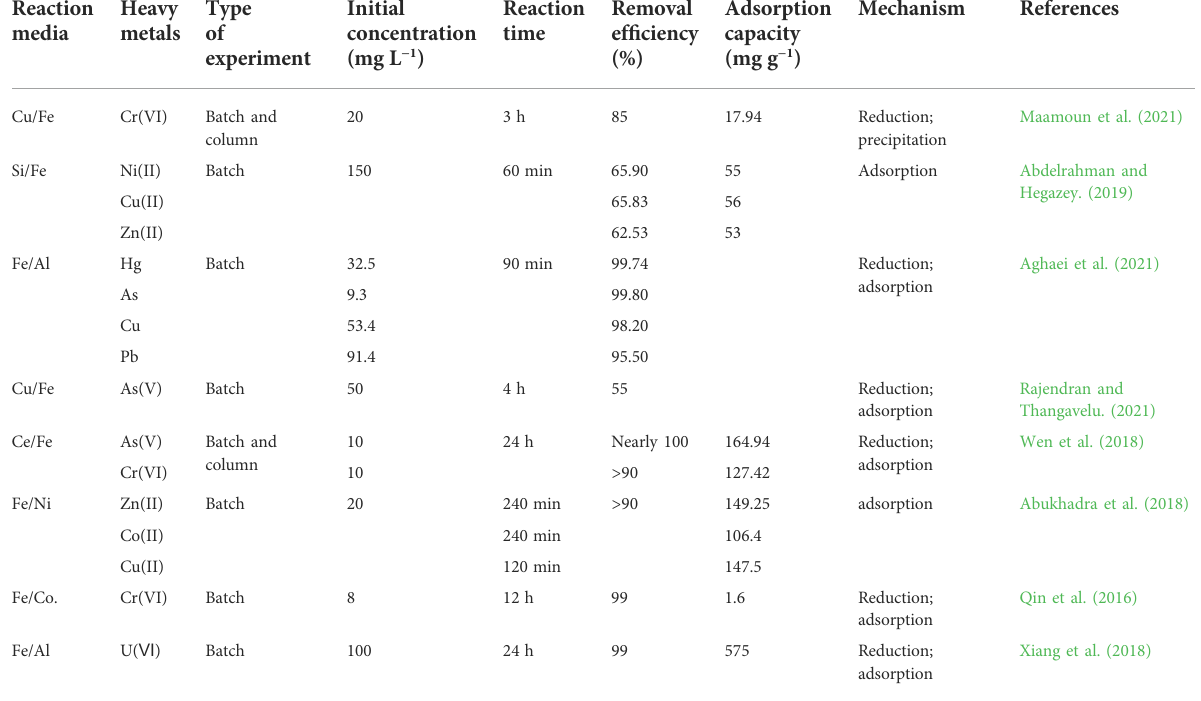
TABLE 3 Application of bimetallic material in PRB treatment of heavy metals in groundwater. Reaction